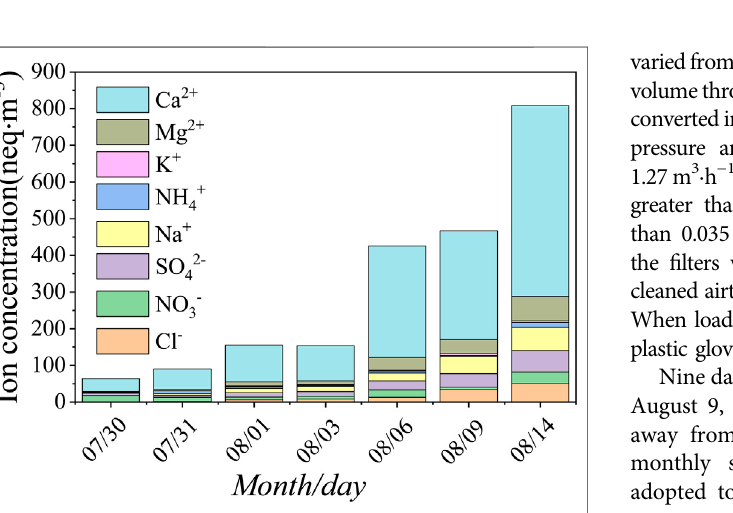
Frontiers in Earth Science |